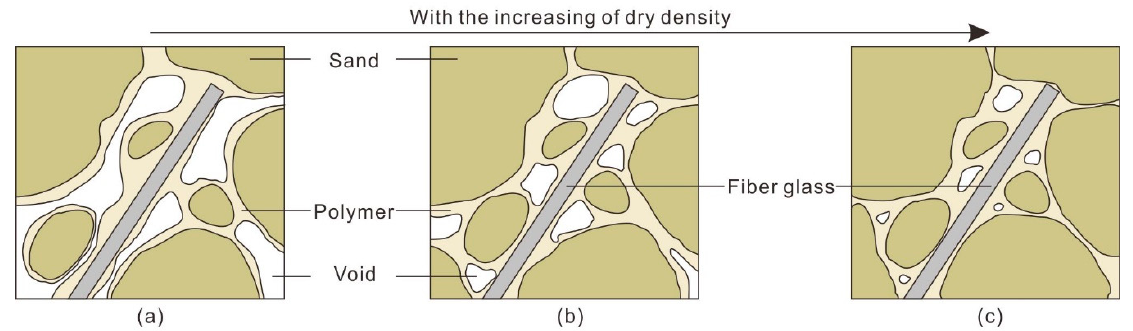
Figure 17. Schematic drawing of microstructure of reinforced sand at different dry density. ( a ) Low dry density; ( b ) Medium dry density; ( c ) High dry density.